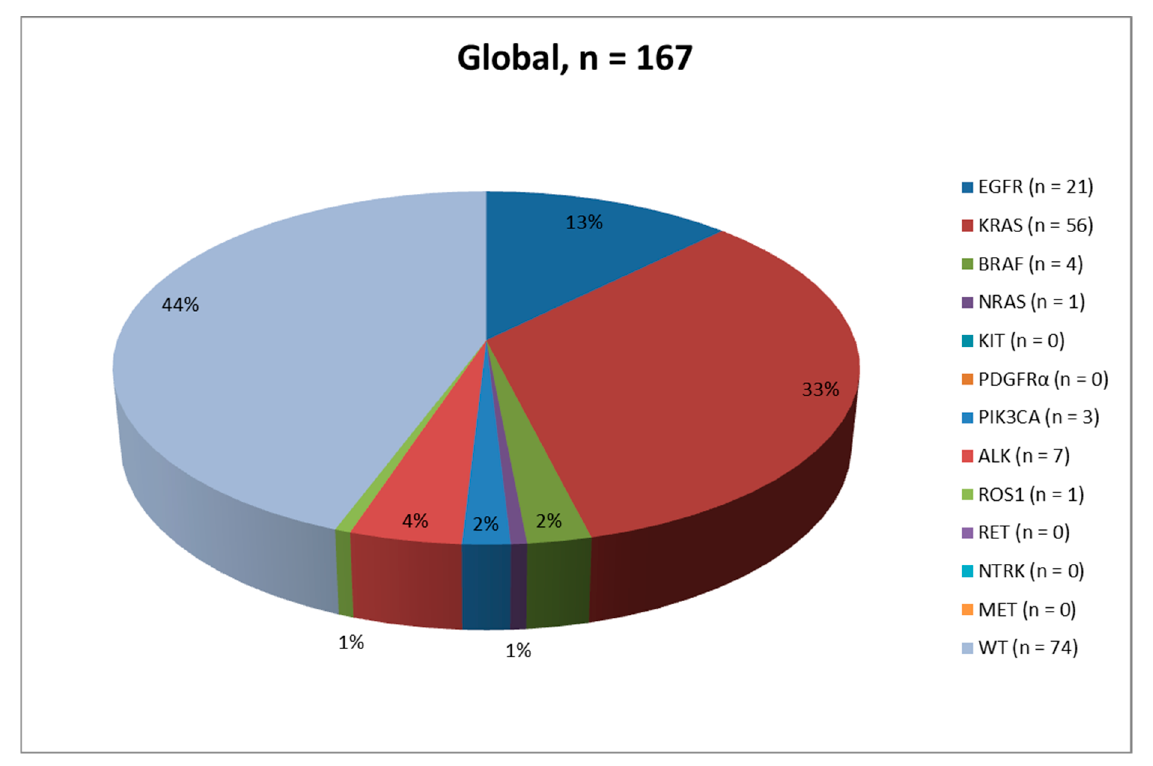
Figure 1. Pie chart describing the mutational landscape in the global advanced stage NSCLC PD-L1 positive patients ( ≥ 1%) population.